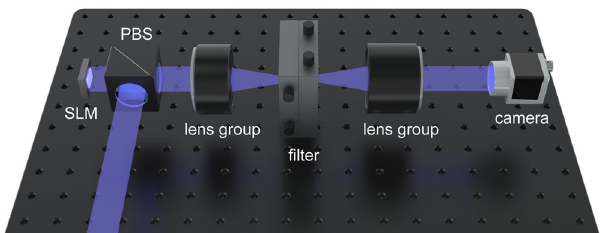
Fig. 8 | Schematic representation of the experimental setup. Collimated RGB lasers were illuminated on an SLM through a polarizing beam splitter (PBS). After the Fourier plane isformed by the fi rst lens group, zeroth order and higher orders ofthegratingphasediffractionimplementedontheSLMwereblockedbythe fi lter. The reconstructed hologram was captured by a camera with a second lens